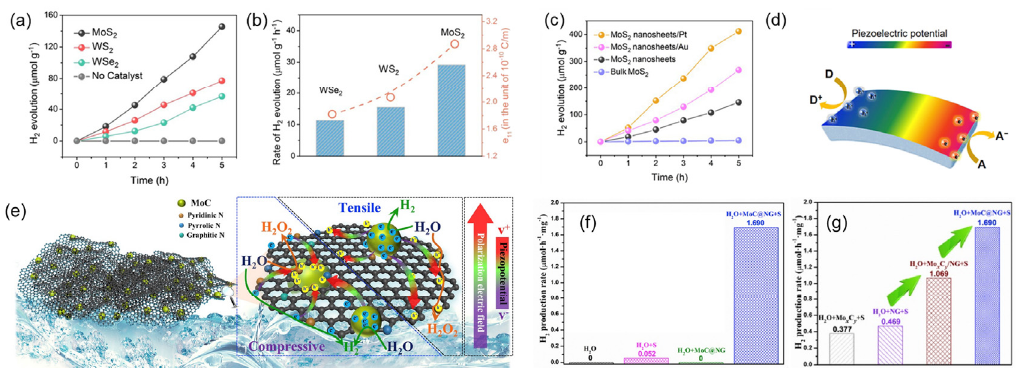
Figure 4. ( a ) Amounts of H 2 production with respect to the different transition metal dichalcogenide (TMD) nanosheets. ( b ) The corresponding H 2 production rate and the e 11 values calculated. ( c ) Amounts of H 2 production with different materials, namely, bulk MoS 2 , MoS 2 nanosheets, MoS 2 nanosheets/Pt, and MoS 2 nanosheets/Au. ( d ) Schematics of the piezoelectric potential induced catalytic reactions in 2D TMD nanomaterials under mechanical force. ( e ) Schematics of piezoelectric effect driven H 2 mechanism. Comparison of H 2 production ( f ) with the bare N-doped graphene (NG) layer and ( g ) with the MoC@NG. ( a – d ) Reproduced from [54], Copyright 2019, Elsevier. ( e – g ) Reproduced from [55], Copyright 2020,